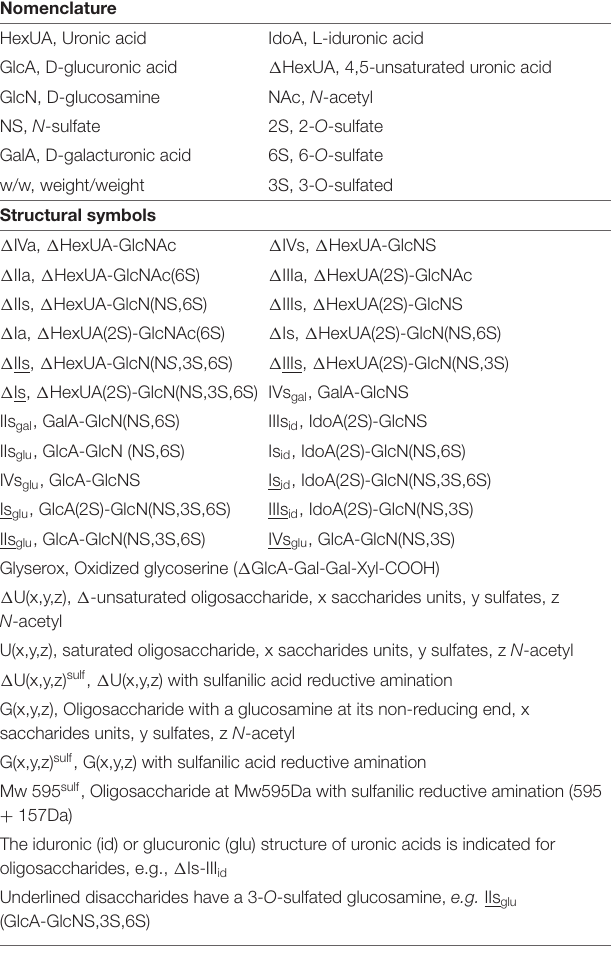
TABLE 1 | Nomenclature and structural